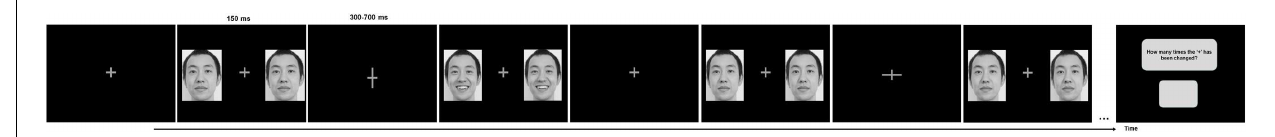
FIGURE 1 | The sample of experimental procedure in the happy oddball condition. A central cross changed (wider or longer) occasionally during each sequence, and participants were instructed to detect the changes and to report how many times the cross had been changed at the end of each sequence. Two identical faces with the same expression were displayed on the bilateral sides of the cross for 150 ms, followed by the inter-stimulus interval of 300–700 ms. The presentation of face-pairs and the changes of the fixation cross were independent.